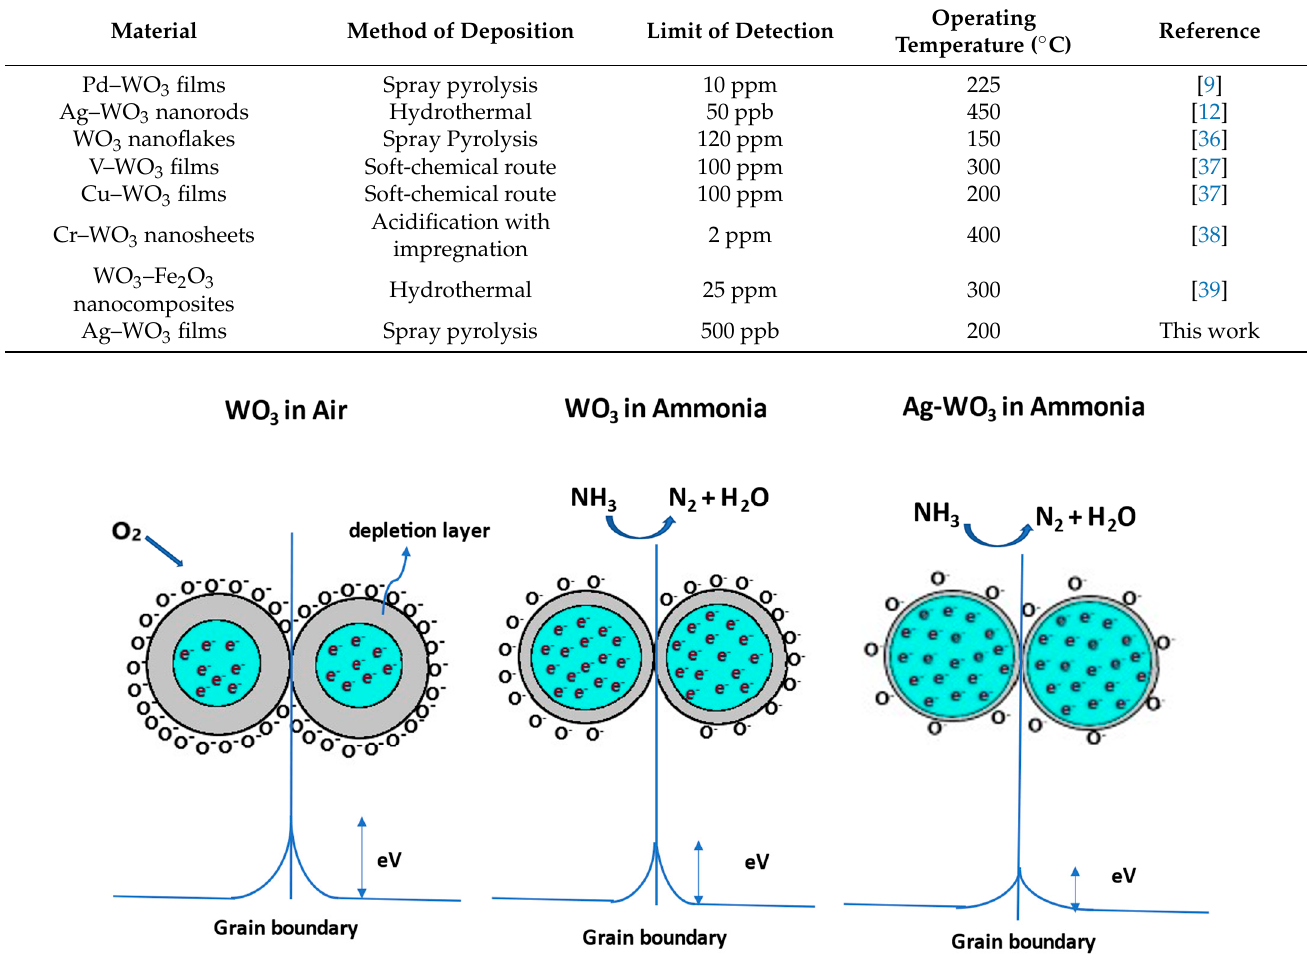
Figure 10. Sensing mechanism involved between the grains of WO 3 and Ag–WO 3 films.